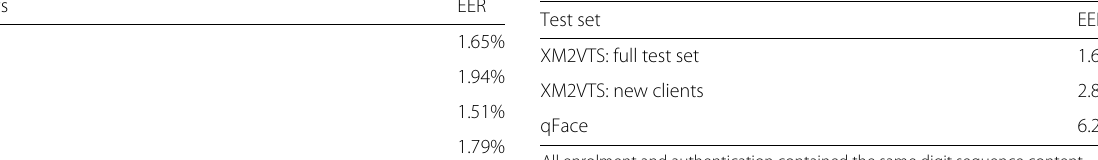
Table 5 Dataset comparison results: the EER showing the comparison between qFace and